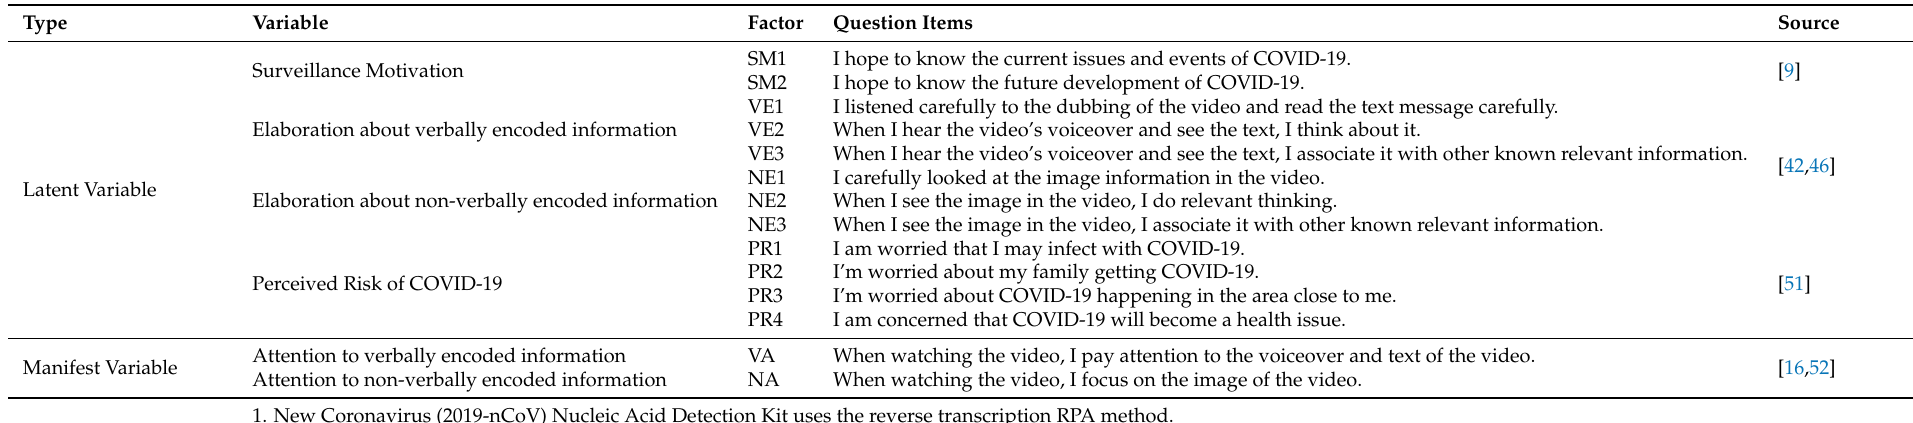
Table 1. Questionnaire